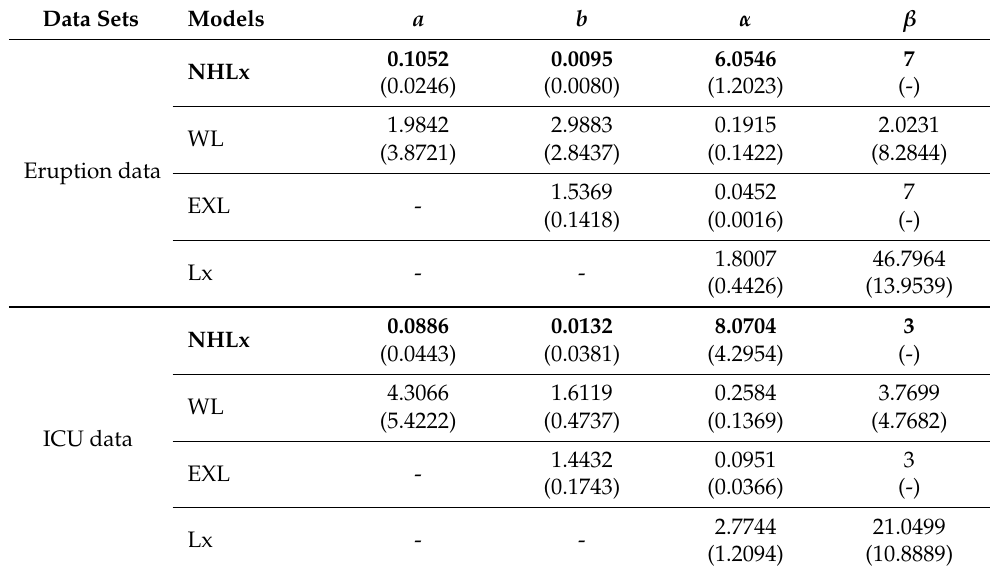
Table 4. MLEs with SEs in parentheses of the considered models for the two data sets.